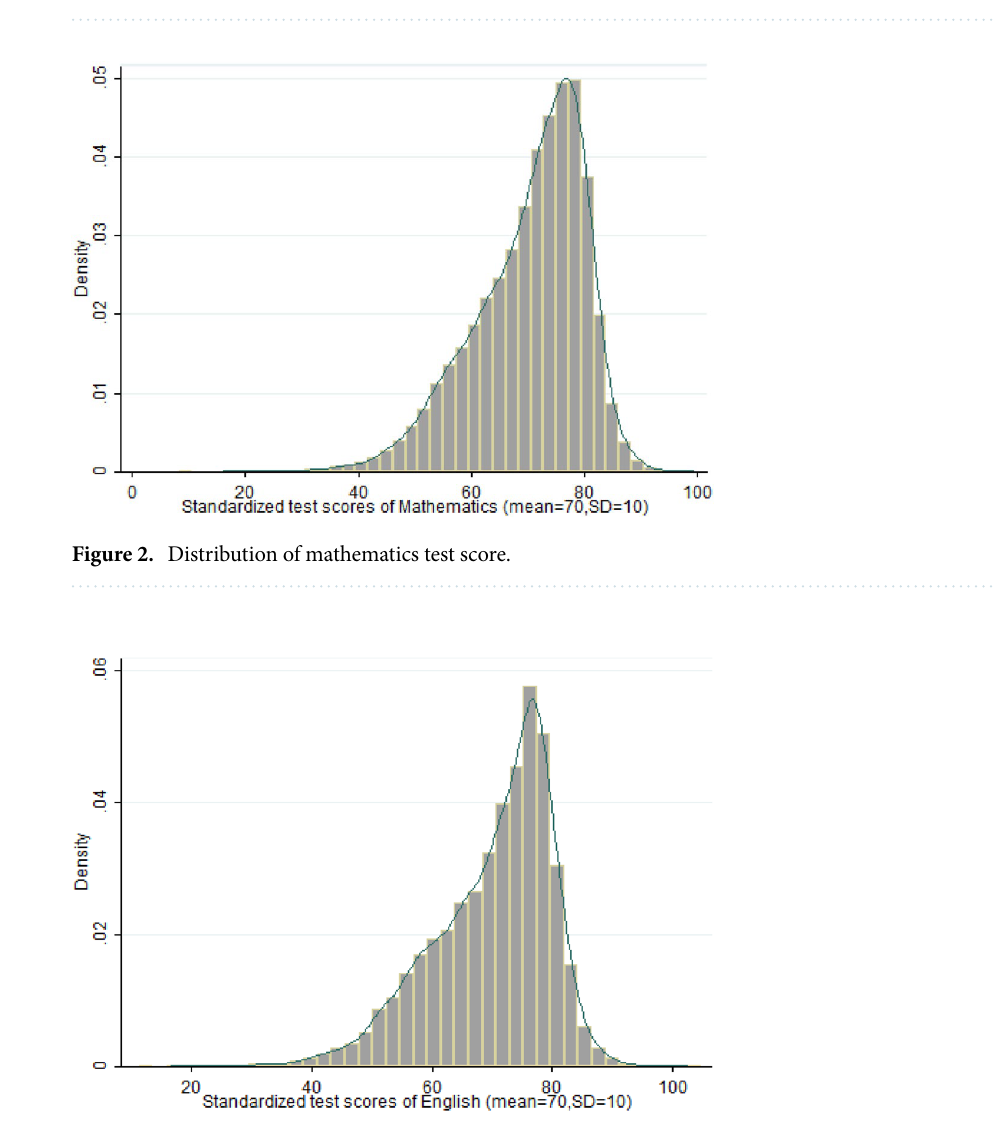
Figure 1. Distribution of Chinese test score.